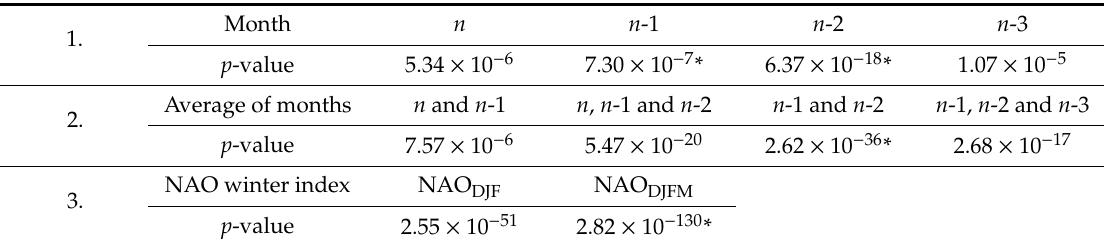
Table 3. Results of the chi-squared test for all analysis of the relationship between pro-pluvia rogations and the NAO index. Asterisks (*) show the most relevant cases. 1., 2., and 3.: see Section 3.2.